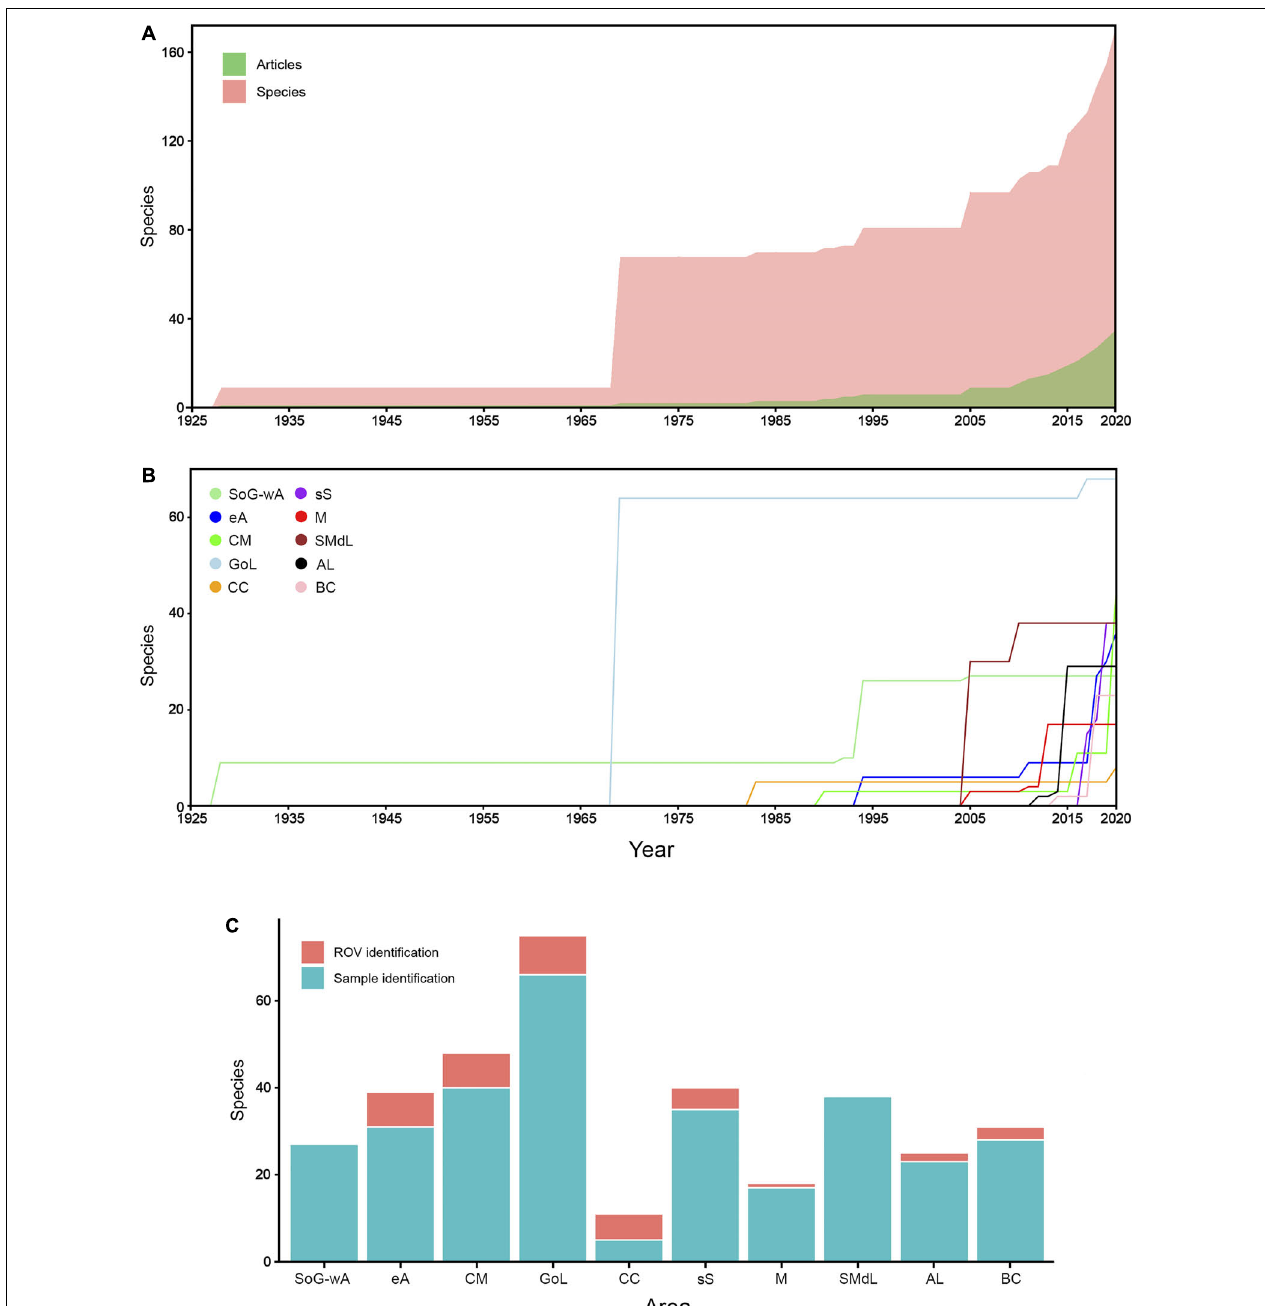
FIGURE 11 | (A) Cumulative timeline of the total number of species (light red) and total number of publications (light green) including data regarding sponge living within Mediterranean CWC. (B) Cumulative timeline of the total number of sponge species associated with CWC on each one of the evaluated areas: SoG-wA (light green); eA (navy blue); CM (bright green); GoL (sky blue); CC (orange); sS (purple); M (red); SMdL (carmine); AL (black); BC (pink). (C) Stacked barplots showing the total number of sponge species identified on each area based on sample identification (duck blue) and/or ROV based identification (red). Note that the sum of both might be higher than the total amount of identified species per area, as the same species might have been identified by both sample and ROV.